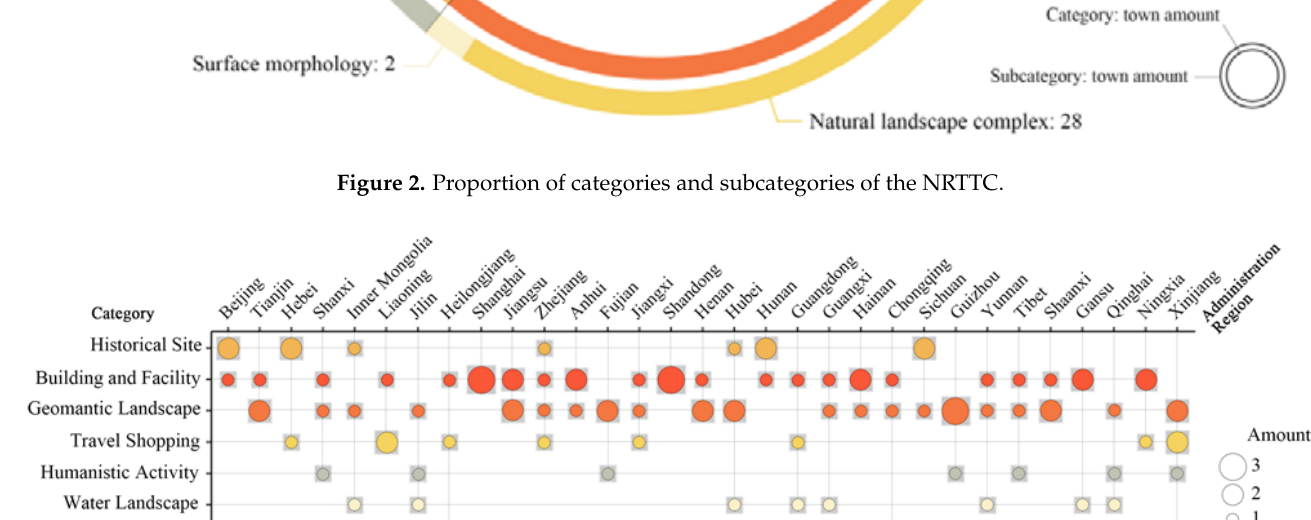
Figure 2. Proportion of categories and subcategories of the NRTTC.